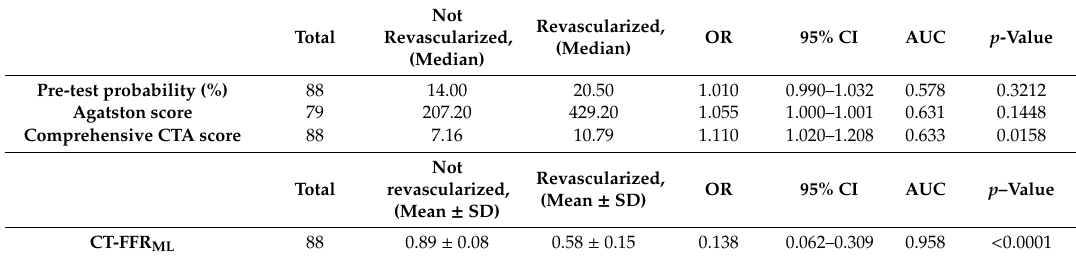
Table 2. Clinical and CT-derived scores and CT-FFR ML .